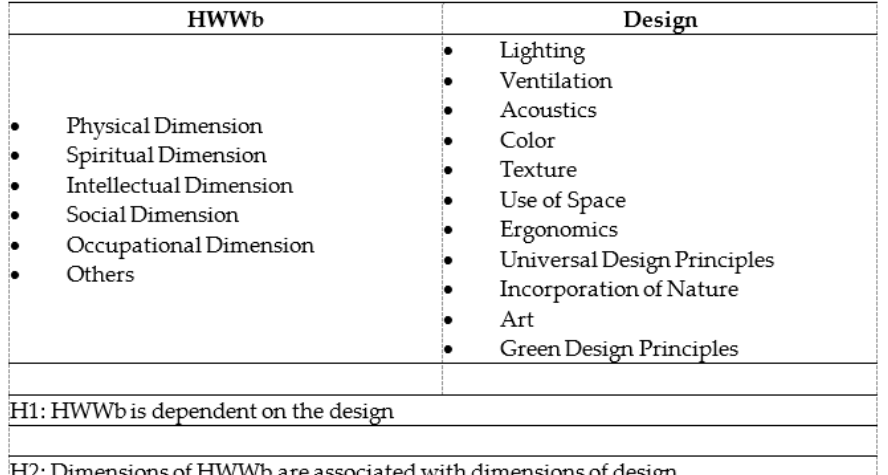
Figure 1. Hypotheses Model.